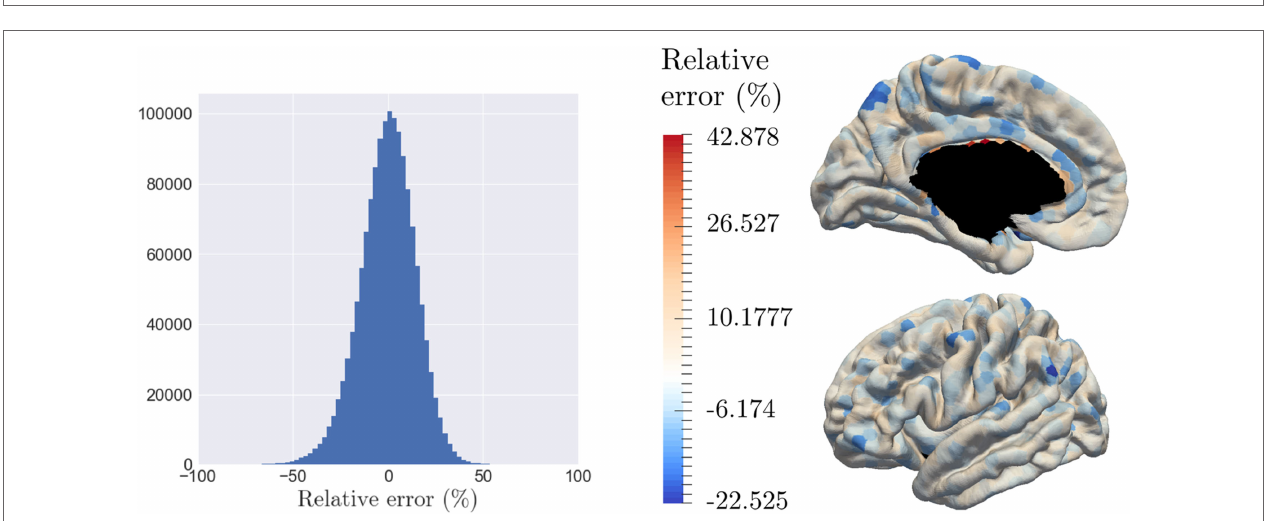
FIGURE 8 | The model is able to reconstruct the data at the individual level, while smoothing the signal over the brain surface, with a relative error randomly distributed. (A) Histogram of the relative error of reconstruction of all individuals across all nodes. (B) Average relative error of reconstruction over each patch, distributed on the graph.